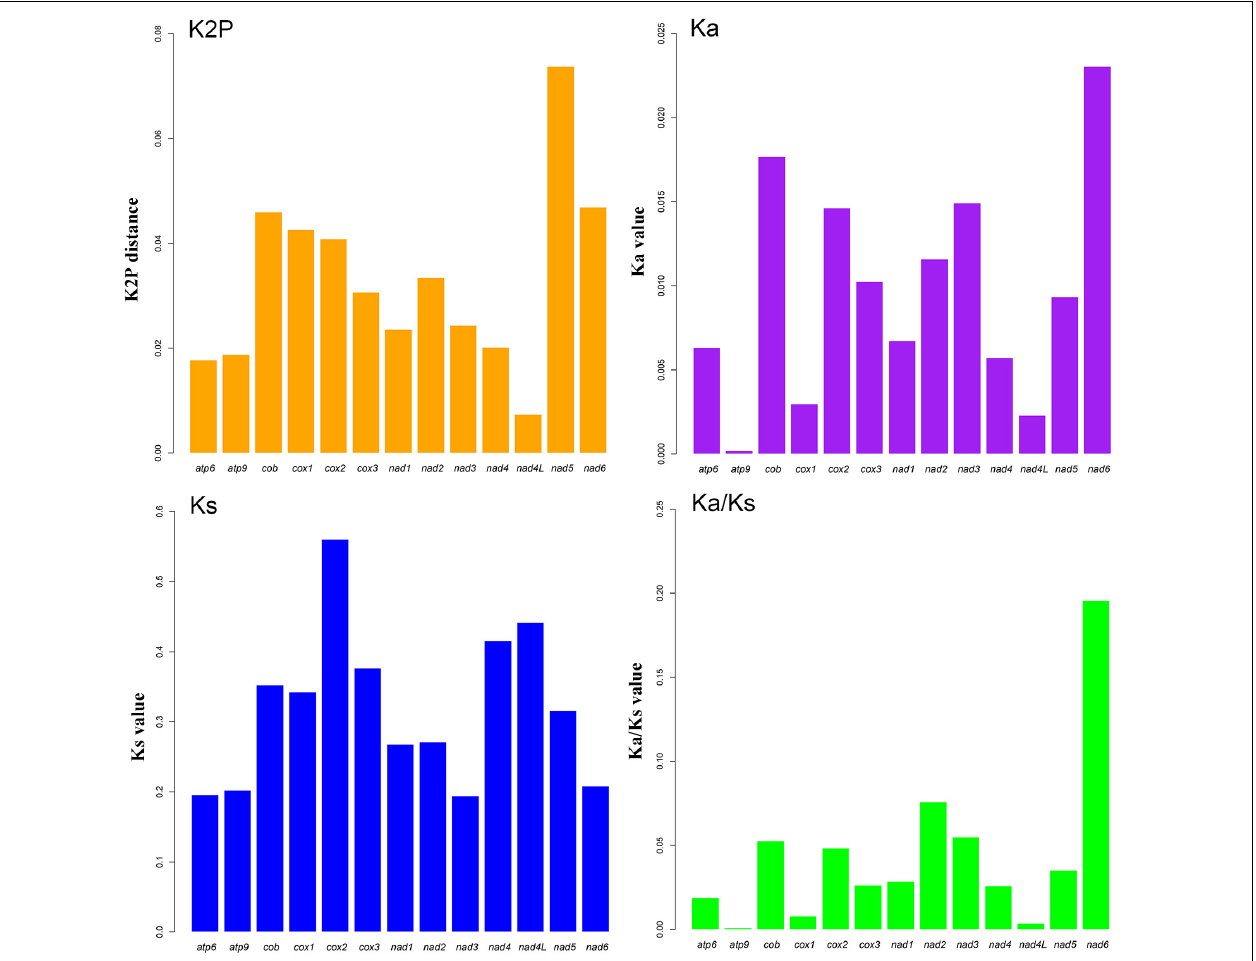
FIGURE 3 | Genetic analysis of 13 protein-coding genes (PCGs) in six Conidiobolus s.s. mitogenomes. K2P, the Kimura-2-parameter distance; Ka, the mean number of non-synonymous substitutions per non-synonymous site; Ks, the mean number of synonymous substitutions per synonymous site. Gene atp8 is not included due to its loss in three species.